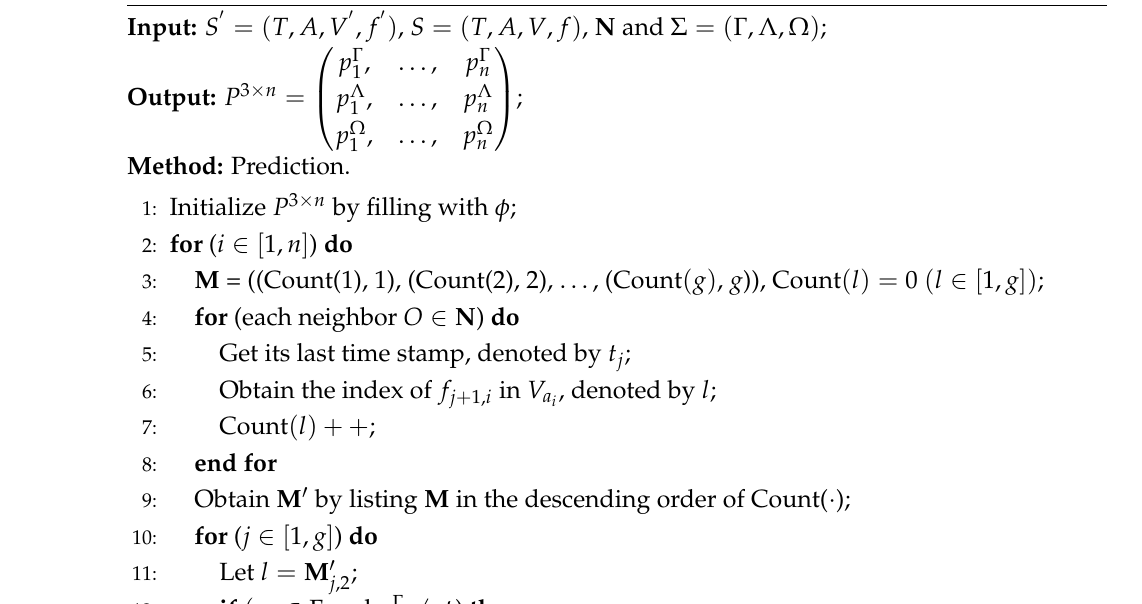
Algorithm 4 Three-way state prediction.